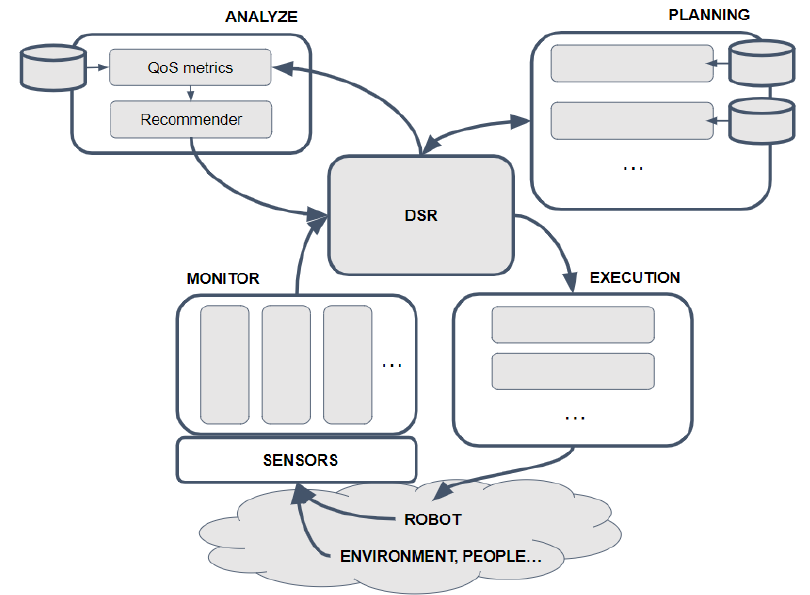
Figure 4. The proposed MAPE-K